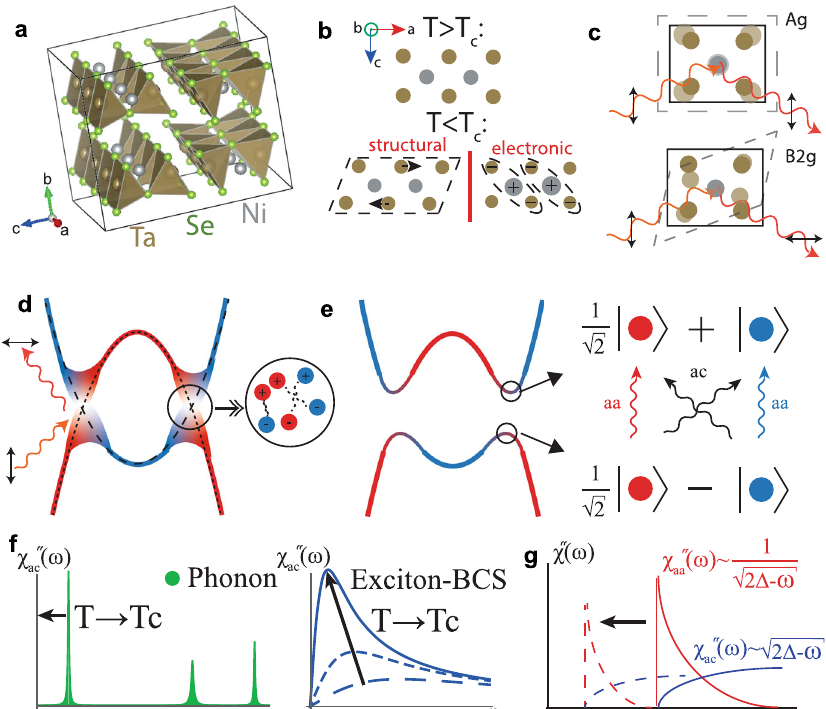
Fig. 1 Schematics of the excitonic insulator physics for Ta 2 NiSe 5 . a Crystal structure in the high-temperature orthorhombic phase. Three unit cells in a direction are shown. b Possible mechanisms of the phase transition: below T c , the symmetry of the lattice can be reduced due to structural distortion or coherent excitonic condensation. c Illustration of the polarization-resolved Raman process: the aa scattering geometry (top) probes excitations with the full symmetry of the lattice ( A g ), while the ac scattering geometry (bottom) couples to the symmetry- breaking excitations with the symmetry of the ac -like quadrupolar order parameter ( B 2g ). d and e Excitonic transition in a semimetal: above T c . d conduction (blue) and valence (red) bands cross at the Fermi level; pre-formed excitons are coupled to interband transitions forming an overdamped collective mode in the B 2g channel. e At low temperatures excitonic order hybridizes the bands, opening a spectral gap. At the gap edge, the eigenstates are equal-weight superpositions of the two bands, shown on the right. As a result, distinct interference effects occur for ac (black arrows) and aa (red/blue arrows) geometries. f Expected Raman spectra for the ac scattering geometry near T c . Left: for a structural transition one of the phonon modes softens to zero energy. Right: for an excitonic insulator, the excitonic mode is overdamped and softens to zero energy at T c . g Expected Raman spectra at low temperature: due to the coherence factors ( e ), the response at the gap edge is suppressed to zero in the ac scattering geometry, but not in aa (see Methods for details). On heating the features move to lower frequencies (dashed